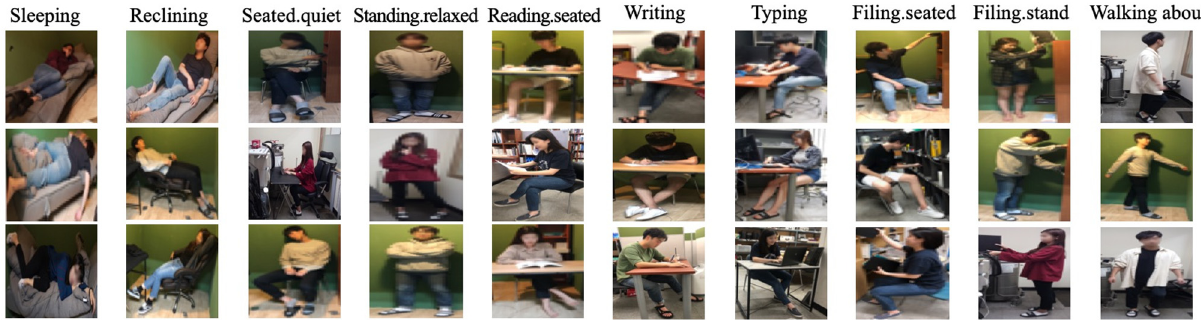
Figure 2. Examples of the images taken in the laboratory.